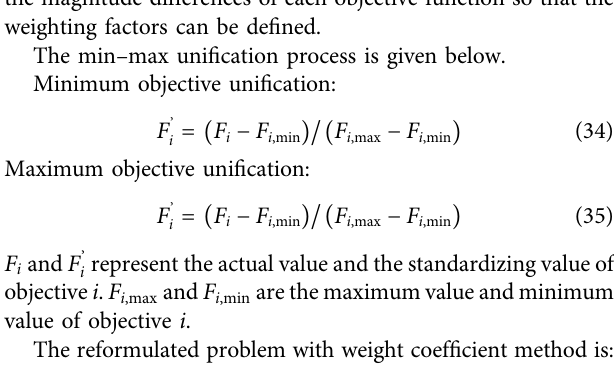
Frontiers in Energy Research |